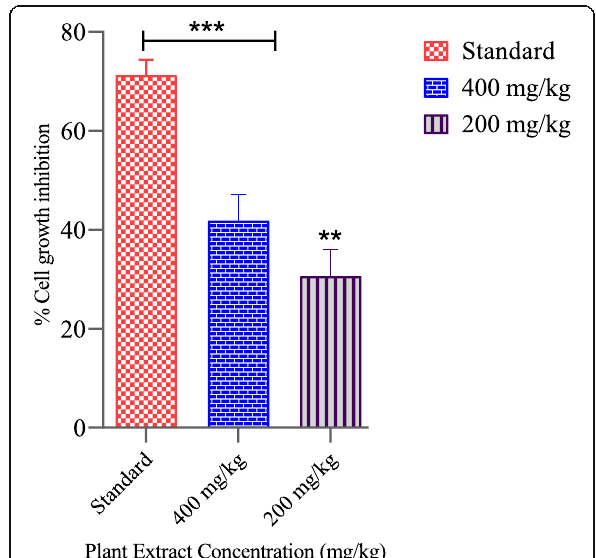
Fig. 2 Effect of Chenopodium album leaf extract against EAC cell growth inhibition in Swiss albino